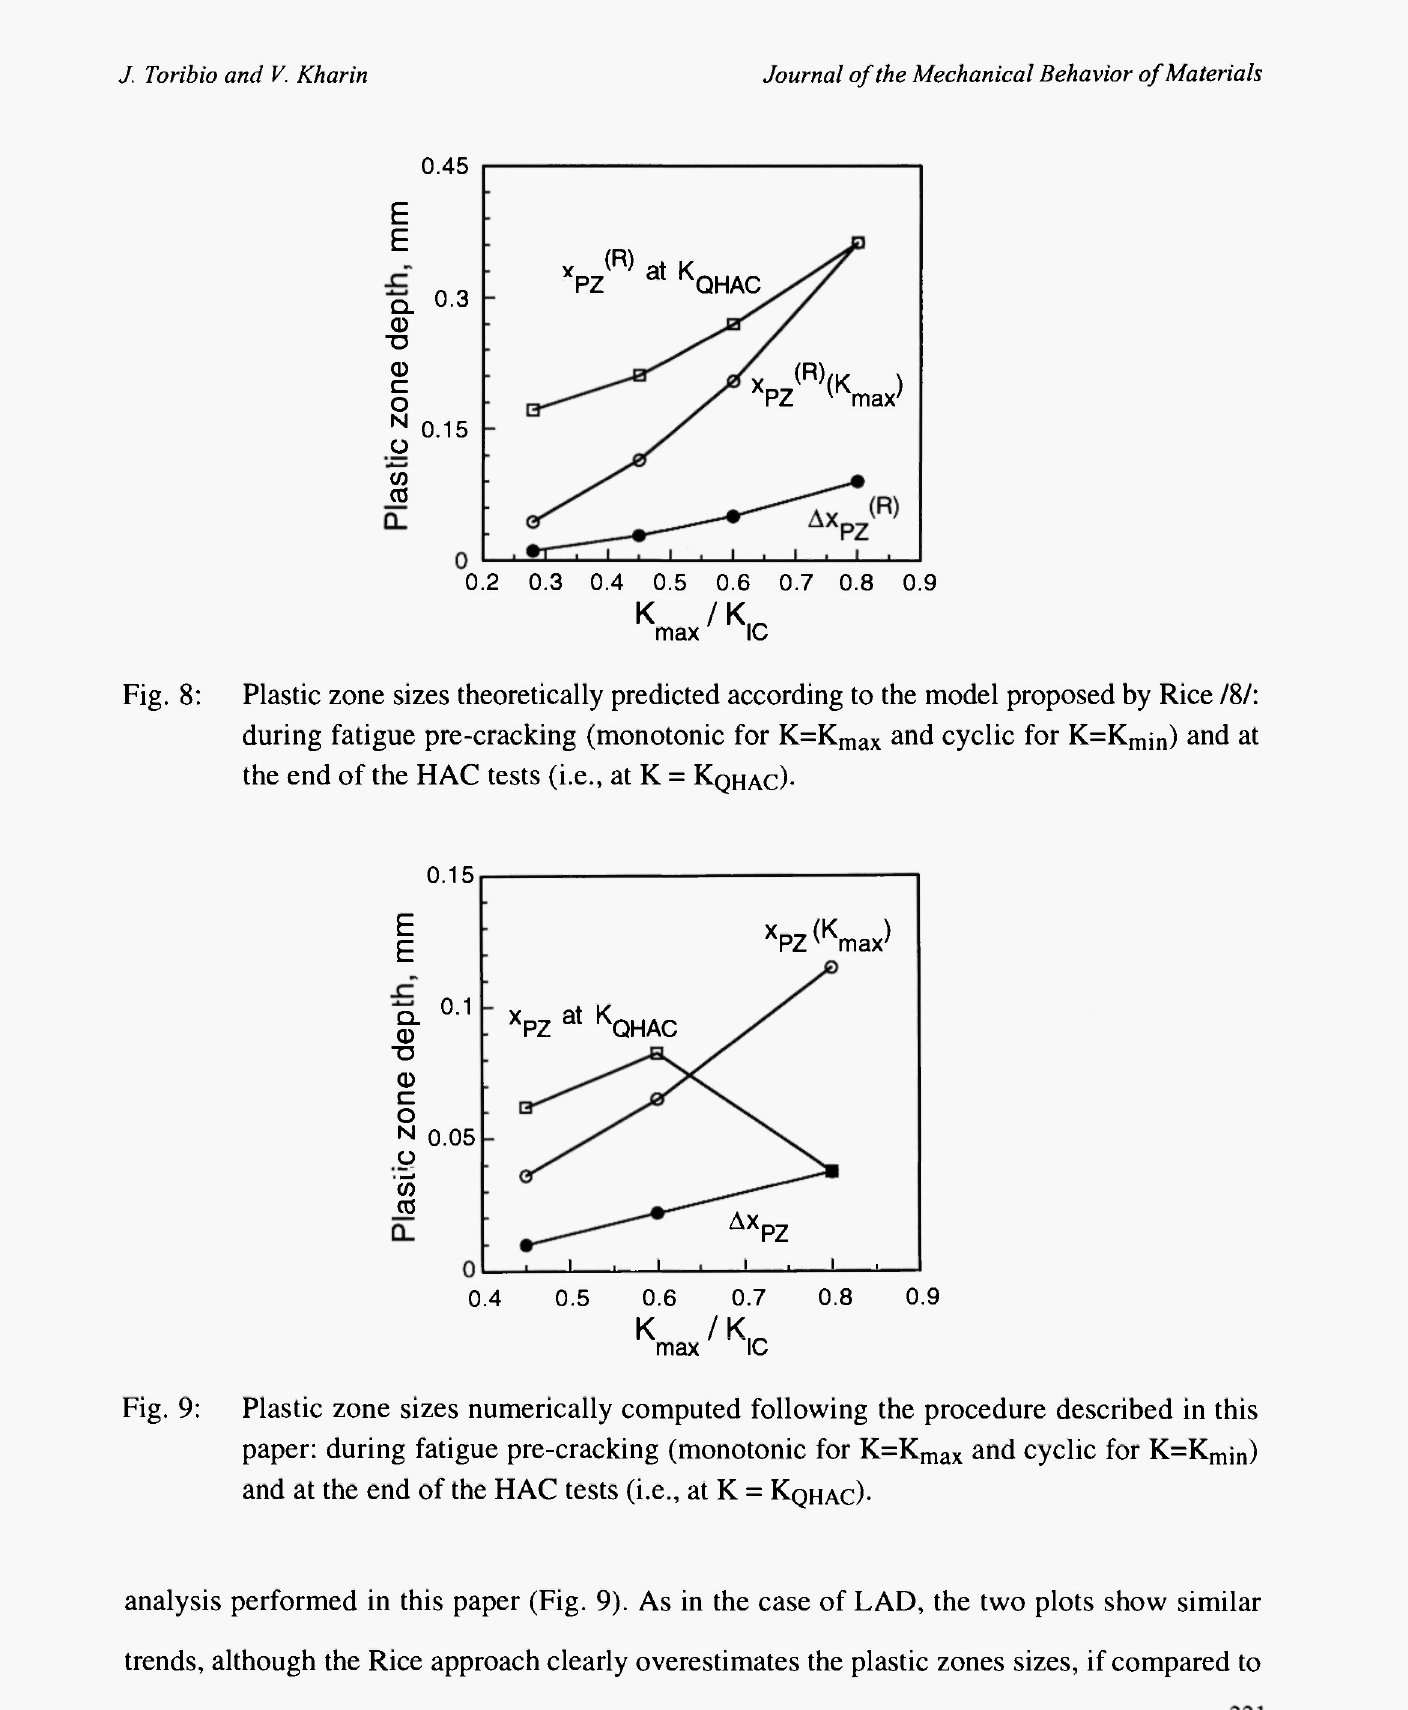
Fig. 9: Plastic zone sizes numerically computed following the procedure described in this paper: during fatigue pre-cracking (monotonic for K=K and at the end of the HAC tests (i.e., at Κ =